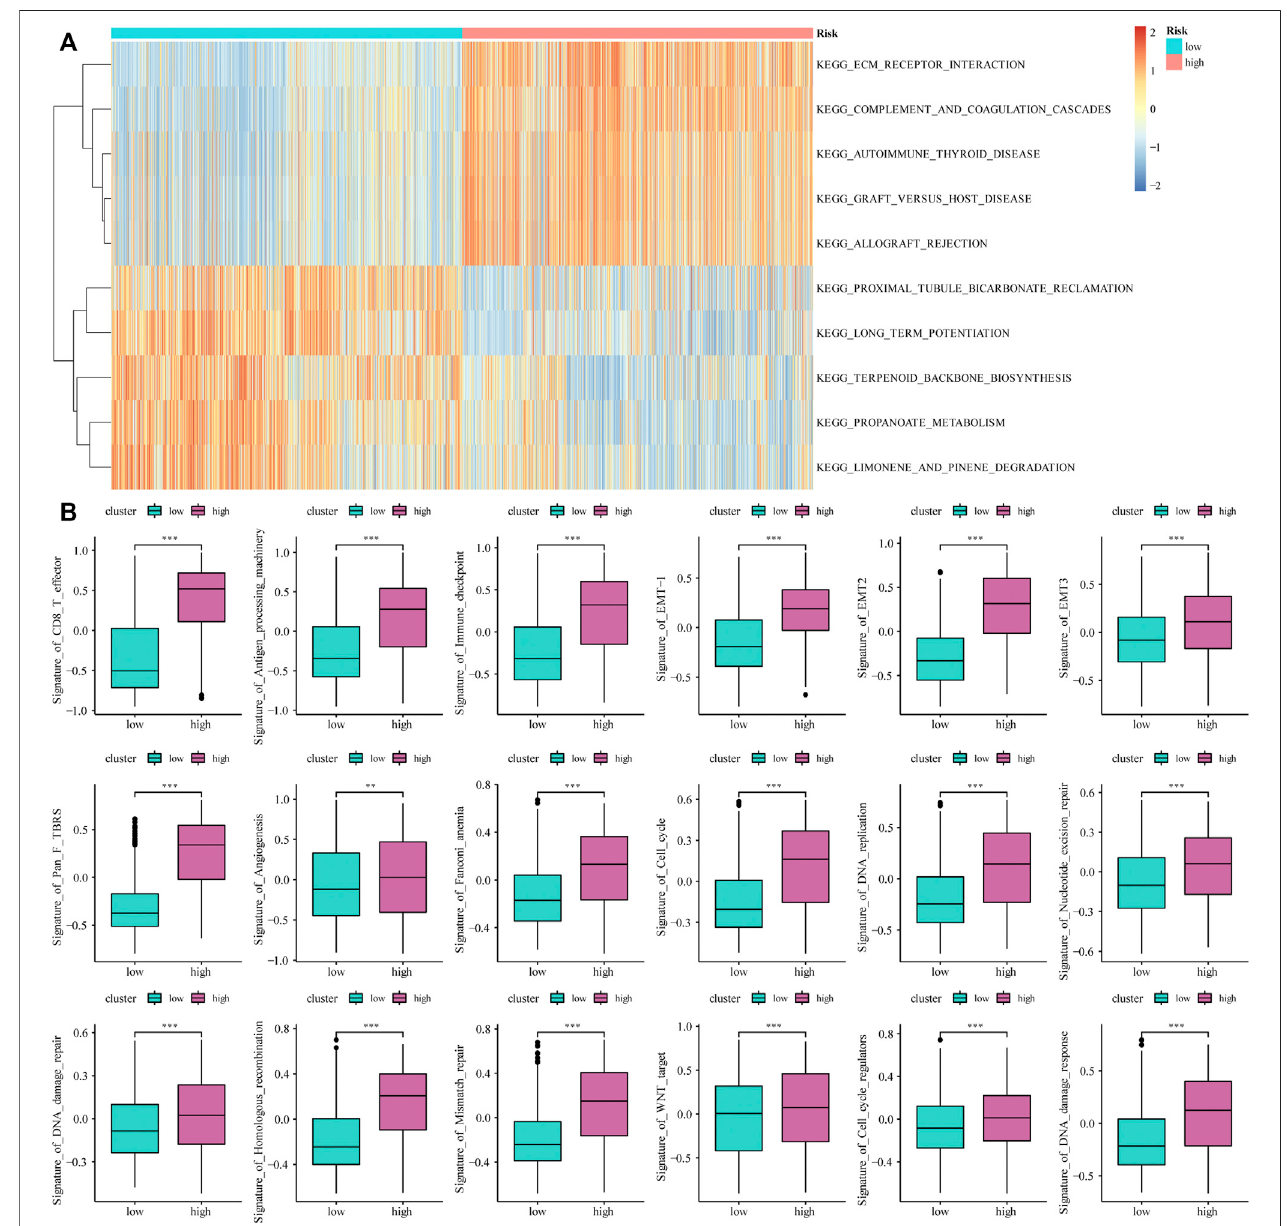
FIGURE 3 | The in fl uence of m6A risk model on different biological characteristics. (A) Based on the gene expression of glioma patients, we performed GSVA on high- and low-risk groups, and used heat maps to show related pathways with signi fi cant differential enrichment; (B) Different pathway (immune-related features, mismatchesandclinicalcharacteristics)enrichmentinthehighandlowriskscoregroups,wherethethicklinerepresentsthemedianvalue,andthebottomandtopofthe box are the 25th and 75th percentiles (interquartile range) (* p < 0.05, ** p < 0.01, *** p <